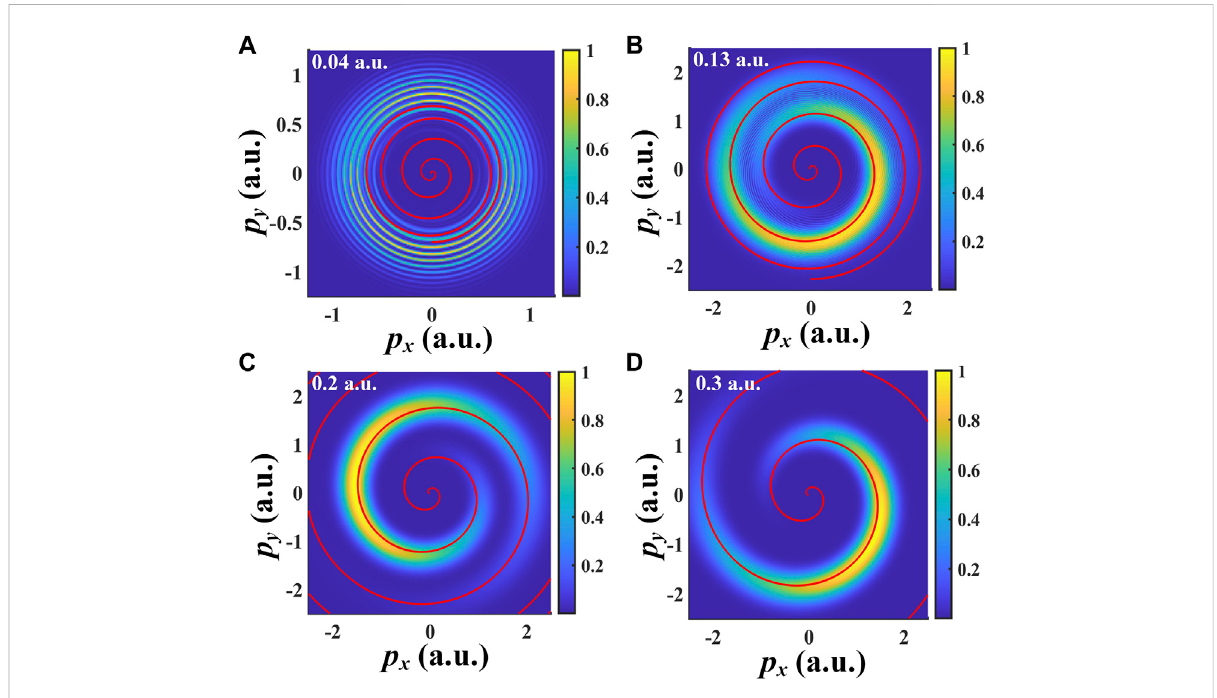
FIGURE 2 The photoelectron momentum spectra calculated by TDSE, corresponding electric fi eld strength are (A) 0.04 a.u. (B) 0.13 a.u. (C) 0.2 a.u. (D) 0.3 a.u. The fi eld-driven momentum − A ( t i ) is shown by the red line.